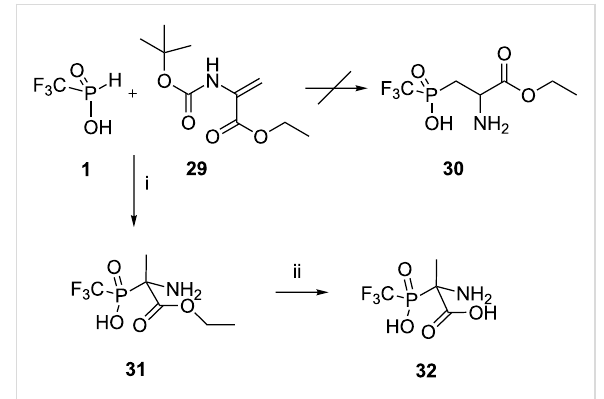
Scheme 8: Interaction of the acid 1 with ethyl 2-( tert -butoxycarbonyl- amino)acrylate ( 29 ). Reagents and conditions: i) an equimolar